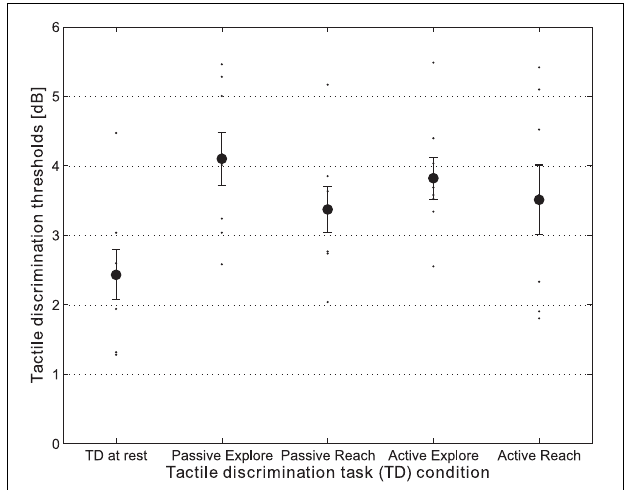
FIGURE 4 | Scatter-plots of the individual threshold data together with the means for the TD task conditions. Vertical error bars represent the standard errors of the